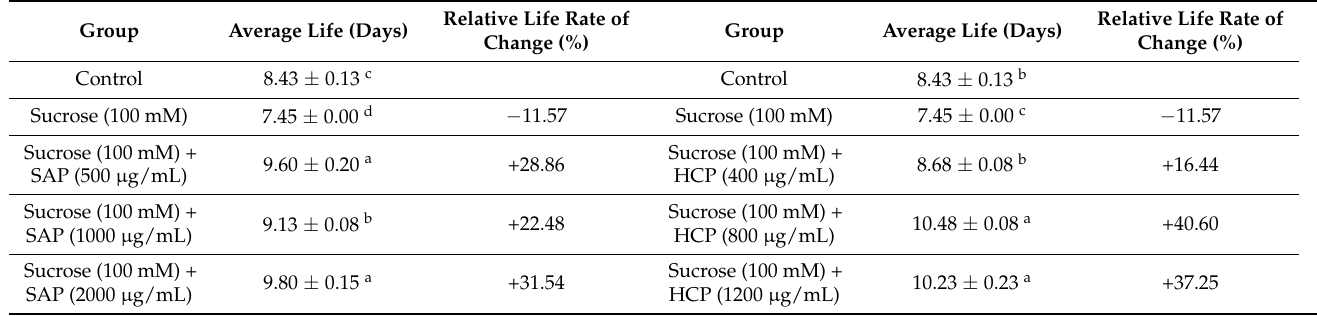
Table 3. The mean lifespan of sucrose-incubated C. elegans treated with SAP and